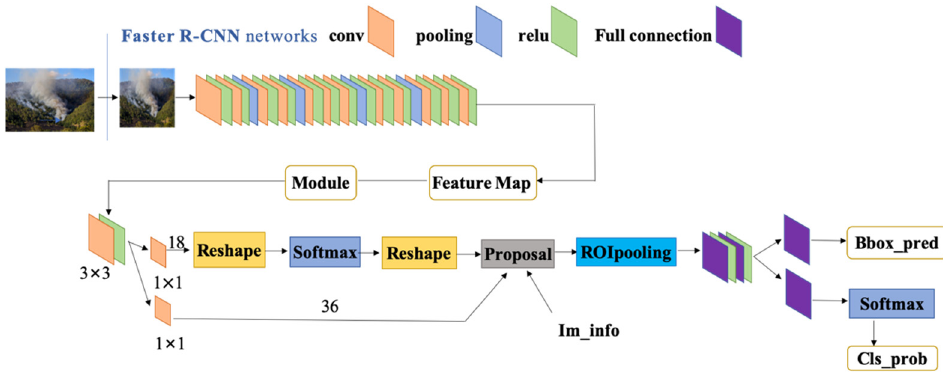
Figure 2. Structure of Faster R-CNN.